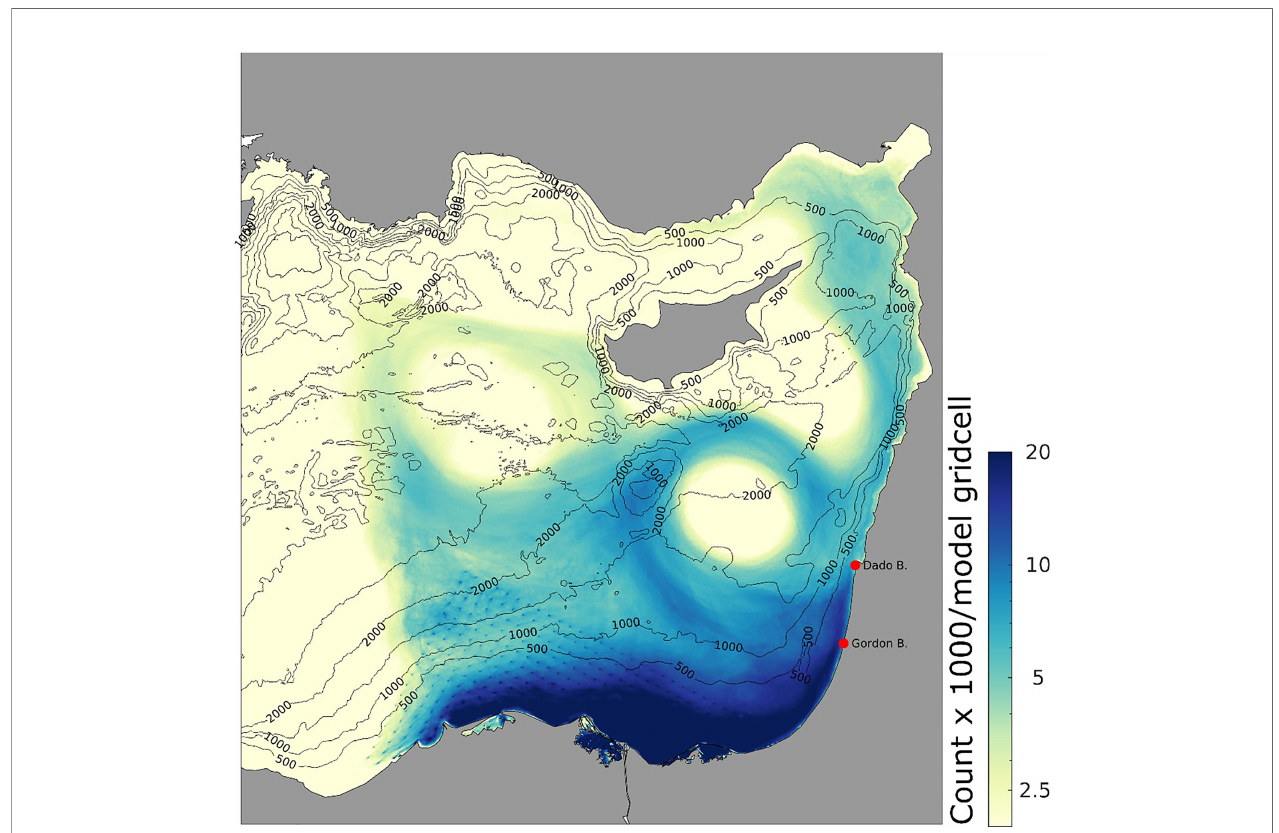
FIGURE 6 | Total number of particle hits within each model gridpoint, released from April 18 th to August 31 st 2018. Release locations along the Egyptian coast are shown in Figure 5